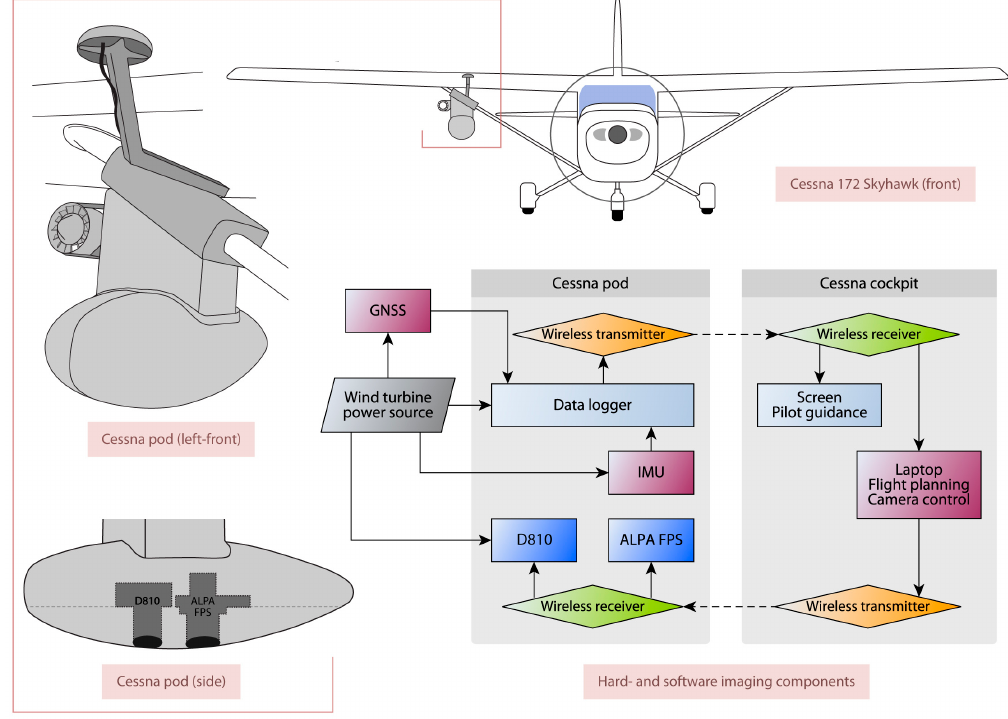
Figure 4. The proposed mobile camera pod for common Cessna types and a scheme outlining all the soft- and hardware components of the complete aerial image acquisition